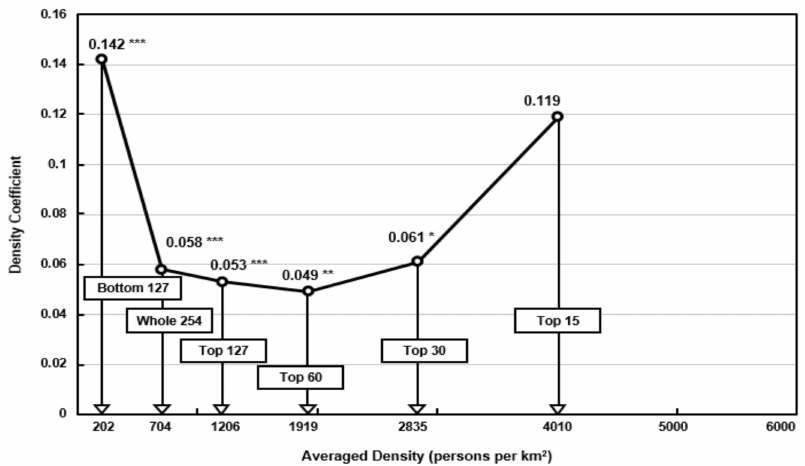
Figure 2. Distribution of density coefficients and averaged density for all cities and the five subgroups of cities (2001–2013). *** p < 0.01, ** p < 0.05, * p <